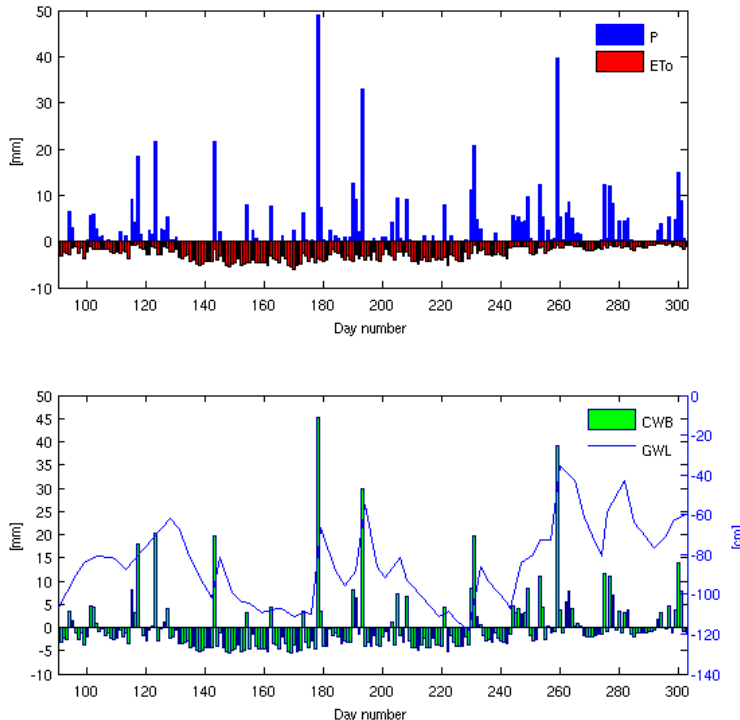
Figure 6. Variation of daily data of meteorological conditions during the vegetation season in the year 2017. P, precipitation; ETo, reference evapotranspiration; CWB, climatic water balance; GWL, ground water level. Table 3. Approximate values of the climatic water balance (CWB), ground water level (GWL), soil moisture content (θv), and soil water potentials (pF) at consecutive depths of the soil root zone during dry spells of 2015 – 2016. Year